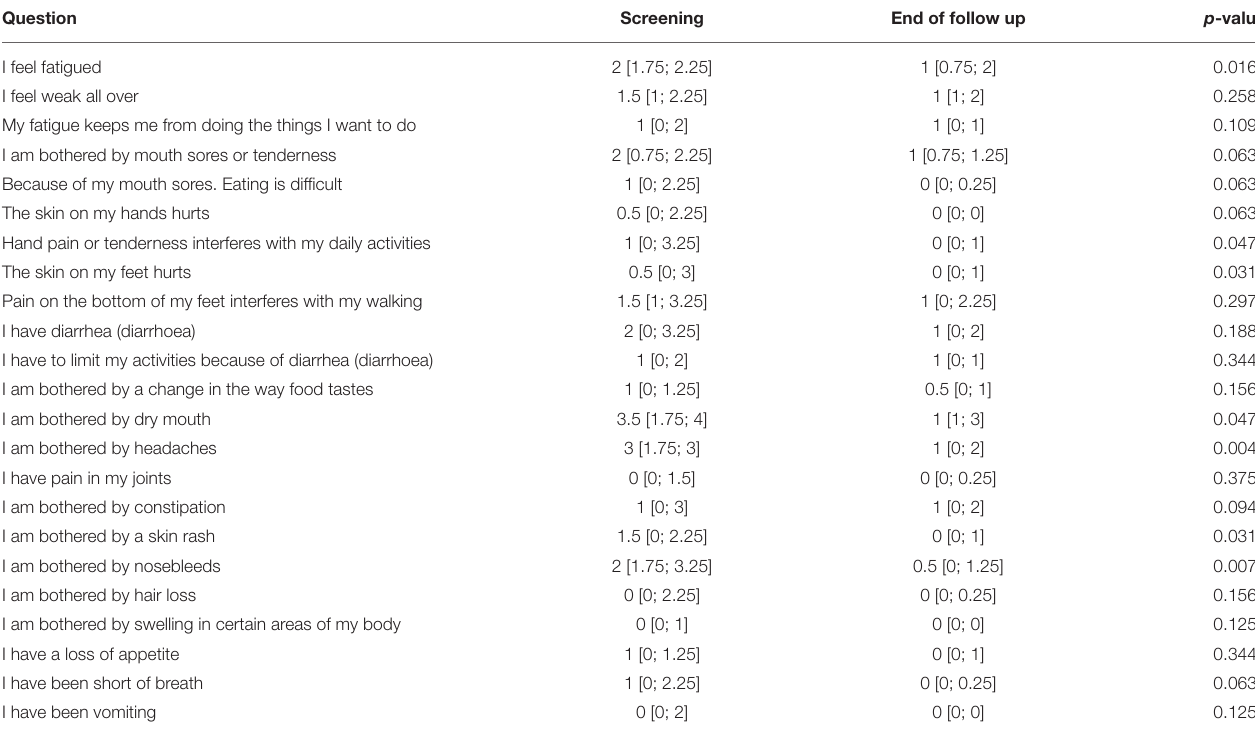
TABLE 6 | Individual questions of FACT-AntiA (Version 4) questionnaire in the entire study cohort. Question